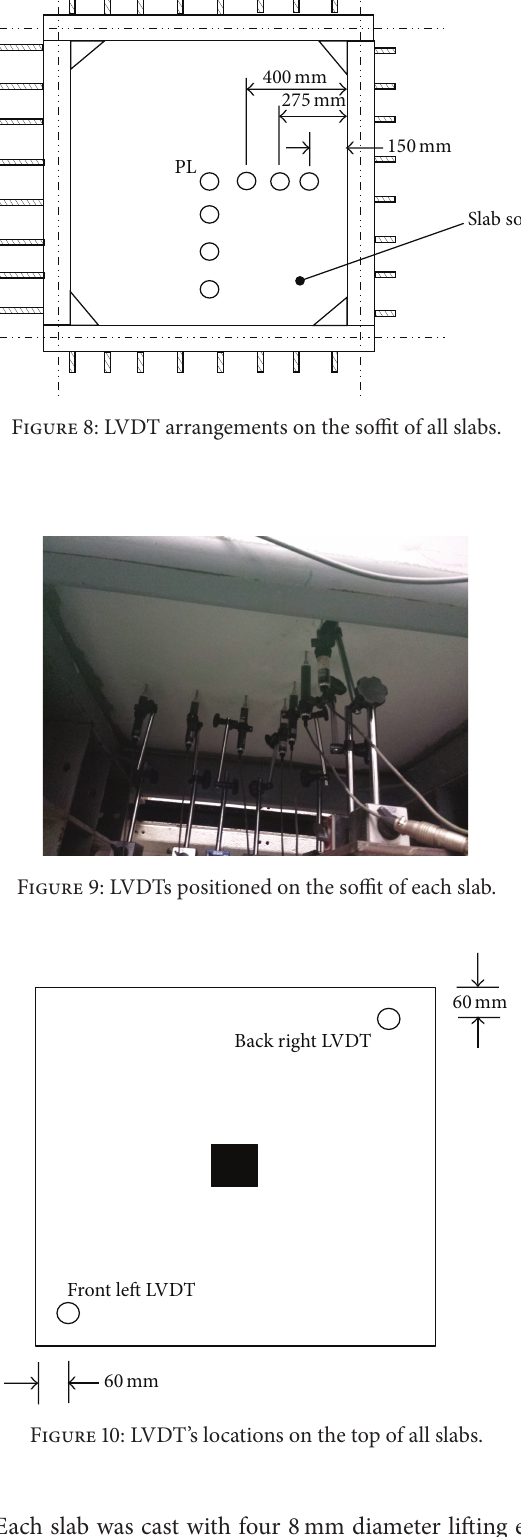
Each slab was cast with four 8 mm diameter lifting eyes (Figure 12) to aid movement. Each eye was lapped 200 mm under the top layer of flexural reinforcement and protruded 90 mm above the surface of the